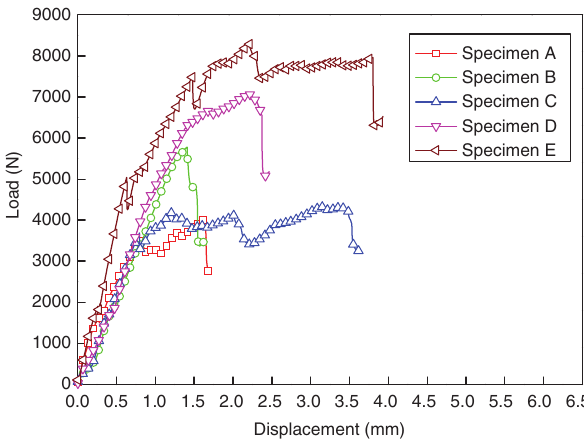
Figure 7: Load-displacement curves tested by experiments.